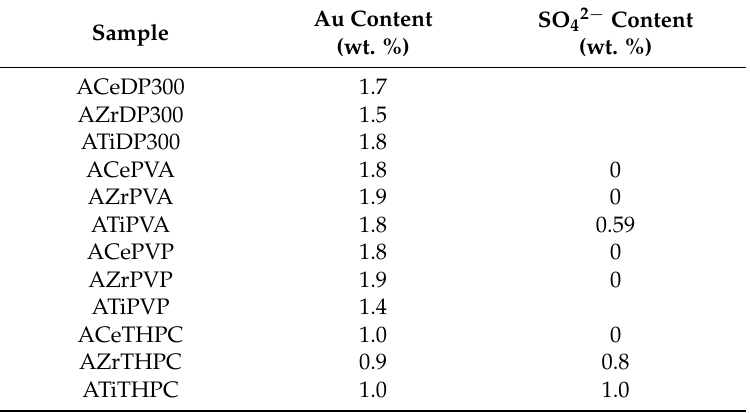
Table 1. Metal and sulphates content by AAS and IC.